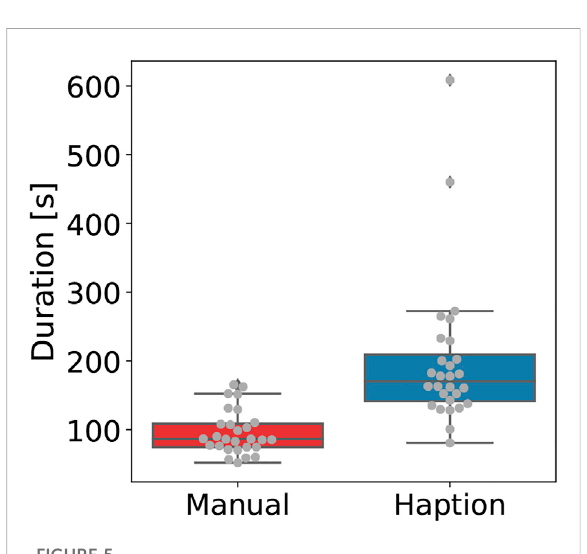
FIGURE 5 Boxplot with overlaid beeswarm plot comparing the duration per